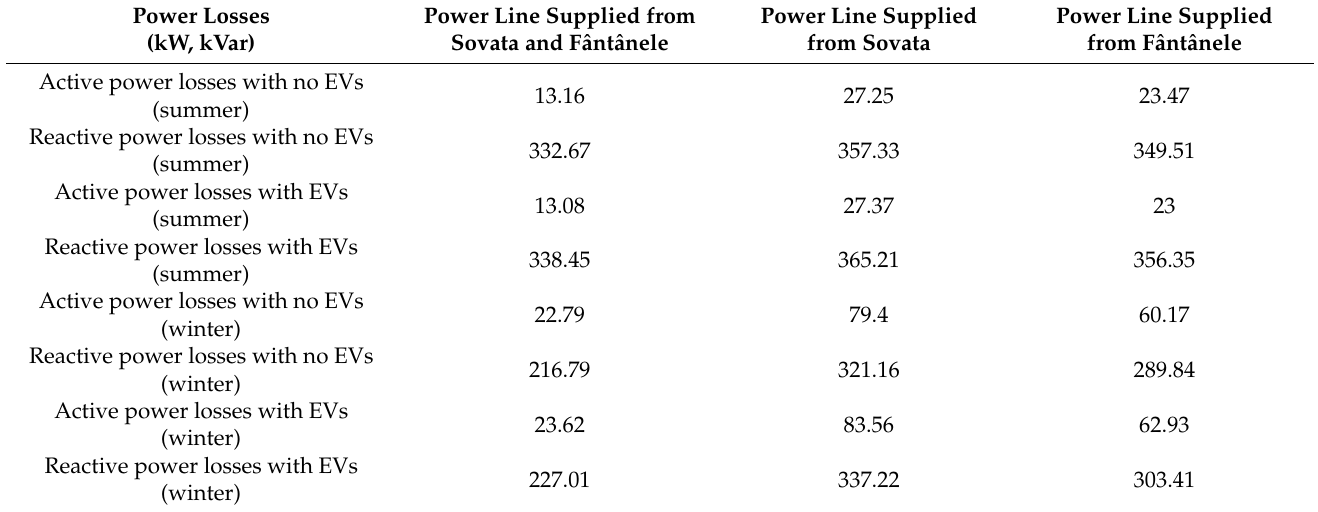
Table 21. Power losses at 13:00 (scenario 4).